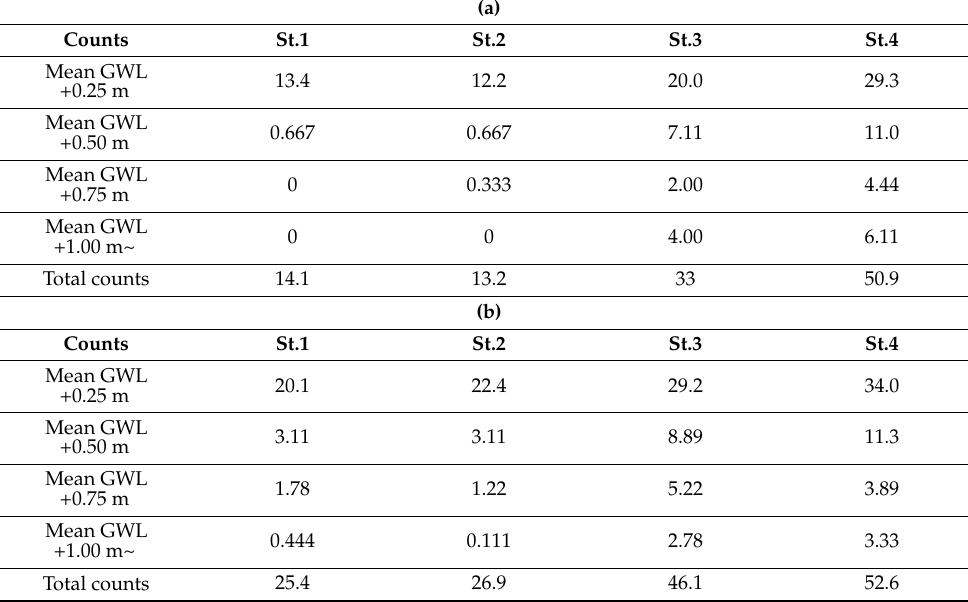
Figure 9. Frequency analysis of groundwater level response to rainfall using the LSTM models: ( a ) Observation point St.2, the upstream side, in 2014. ( b ) Observation point St.4, the downstream side, in 2016. Table 3. Annual mean frequency of groundwater level response to rainfall: ( a ) Before the meandering stream channel restoration. ( b ) After the meandering stream channel